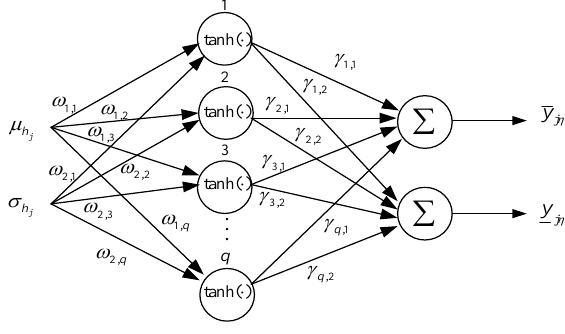
Figure 1. Three-layer artificial neural network (ANN).